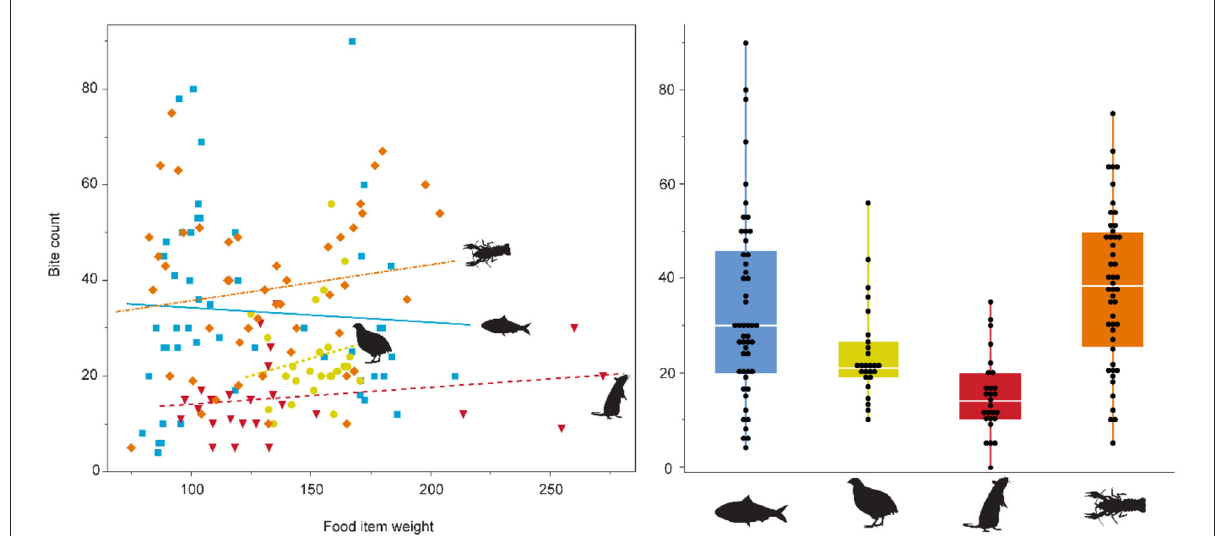
FIGURE1 Bite count vs. food item weight (g), and per diet. No relationship between diet type and bite count, or food item weight and bite count was found. Overall, the alligator feeding on rats displayed the least bites per feeding bout, while the crawfish feeder showed the most bites. The pelleted diet is not displayed, as the alligator did not exhibit “chewing” behavior on pellets. Sardine = blue, quail = yellow, rat = red, crawfish = orange.